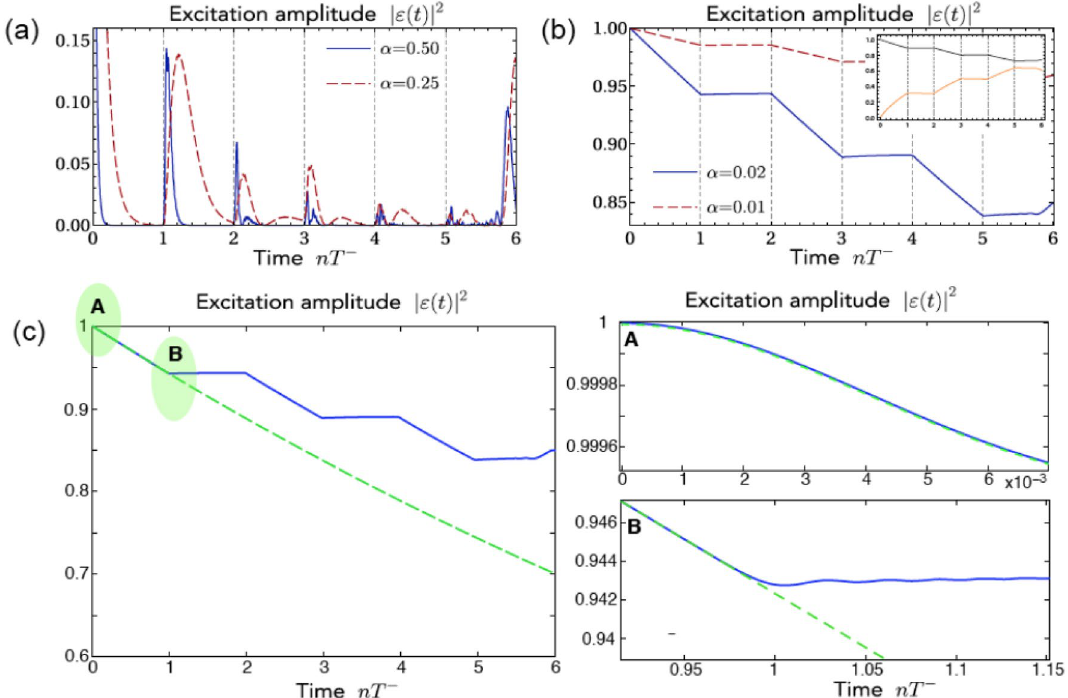
2 502 , ε( t ) Figure 2. (color online) ( a , b ) Evolution of the excitation amplitude , solution of Eq. (6) for N = | | 0.25 and α 0.50 ) In this regime a non exponential decay 1 and different values of α . ( a ) ( α J ρ = = = = 0.01 and α 0.02 ) In this regime nT dynamics is observed, in which multiple revivals occur for t − . ( b ) ( α = = = 6 T intermittent blockade of the decay is observed until the time t − ; at longer times feedback from the slow ∼ modes arises, which breaks intermittent decay suppression. Inset: evolution of purity (black) and von Neumann 0.02 . ( c ) Comparison between decay dynamics for α 0.02 , N 502 [solid curve, as entropy (orange) for α = = = 0.02 , N in panel ( b )] and for α (dashed curve, continuous limit without delayed feedback). Note that = = ∞ for 0 < t < T − the two curves are overlapped. The plots on the right side in A and B depict an enlargement of 0 , where the decay is parabolic (Zeno dynamics, panel A), and near the decay dynamics near the early time t = T the time t − , where stopping of decoherence decay is observed in the finite N case due to coherent delayed = feedback.